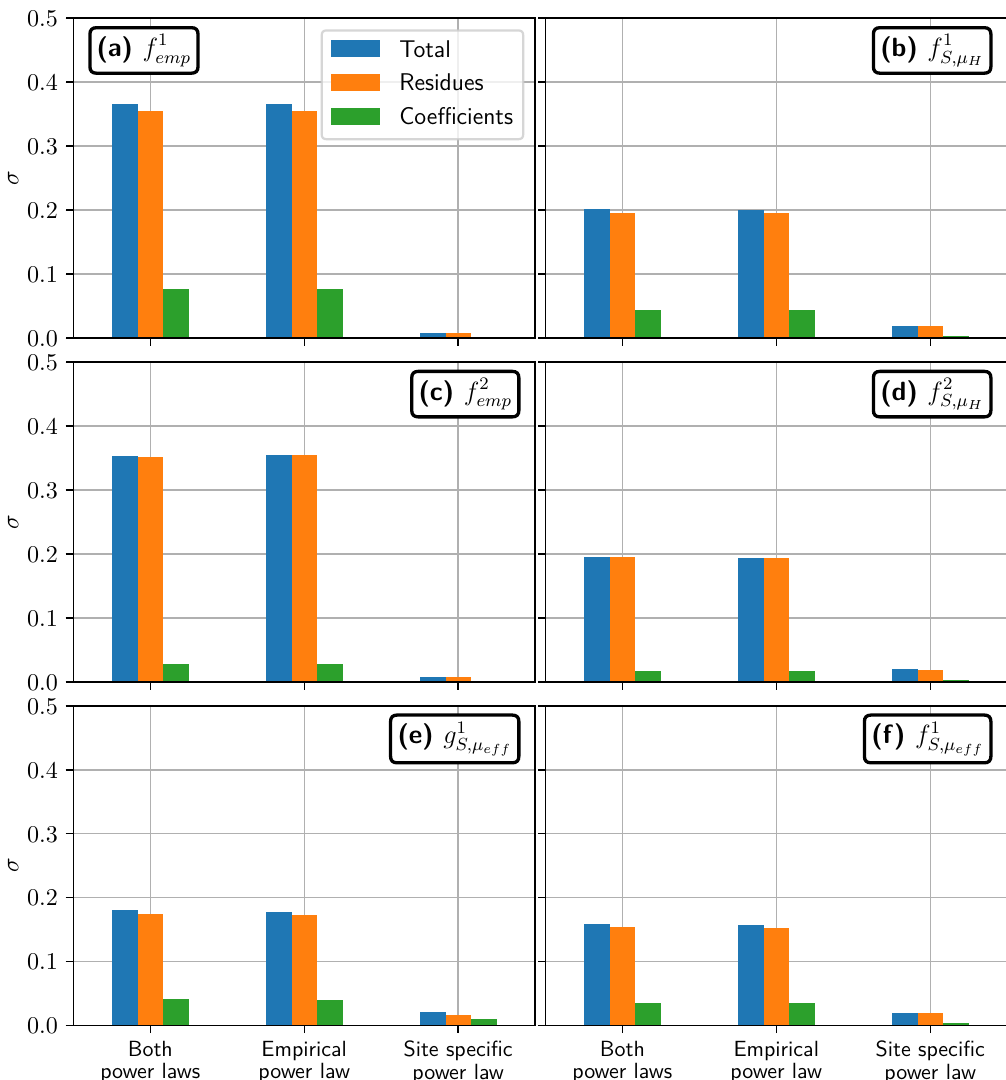
Figure A4. Uncertainty in travel distance estimation for the Fei Tsui Road cliff case study. ( a – f ), and symbology are the same as for Figure